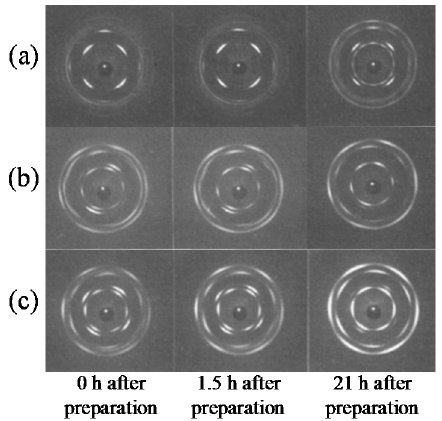
Figure 23. X-ray diffraction patterns of: non-sheared ( a ); sheared parallel ( b ); and perpendicular ( c ) to the [110] direction of the oriented iPBu samples taken during the II-I phase transition for 0, 1.5 and 21 h after sample preparation. Reproduced with permission from Ref. [130], copyright 1985 Springer-Verlag.